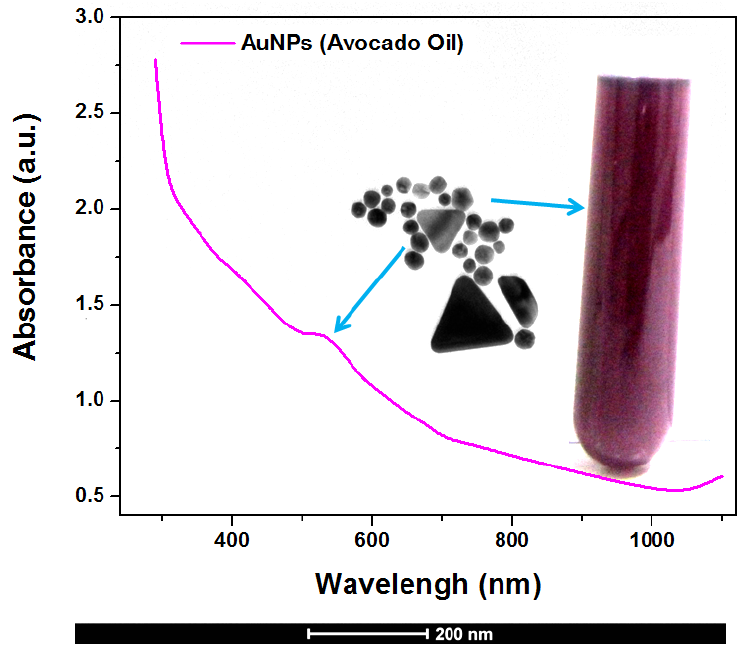
Figure 4. Visual, UV-visible, and transmission electron microscopy images of synthesized gold nanoparticles using avocado oil.